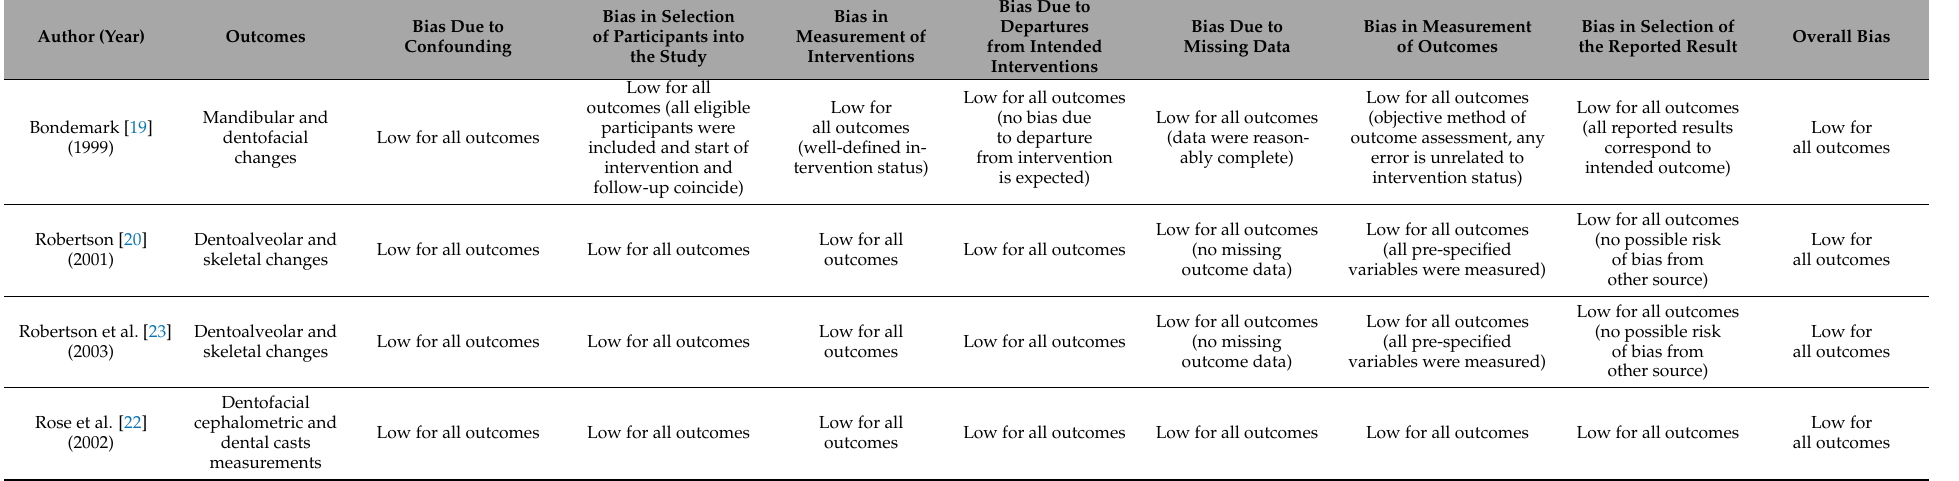
Table 5. Risk of bias assessment for non-randomized controlled